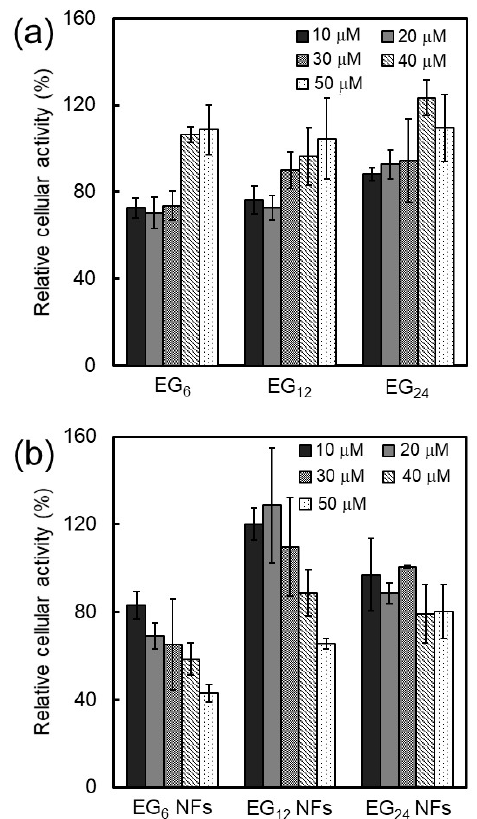
Figure 7. Evaluation of the cytotoxicity of EG n peptides ( a ) and EG n NFs ( b ) against JAWS II cells.